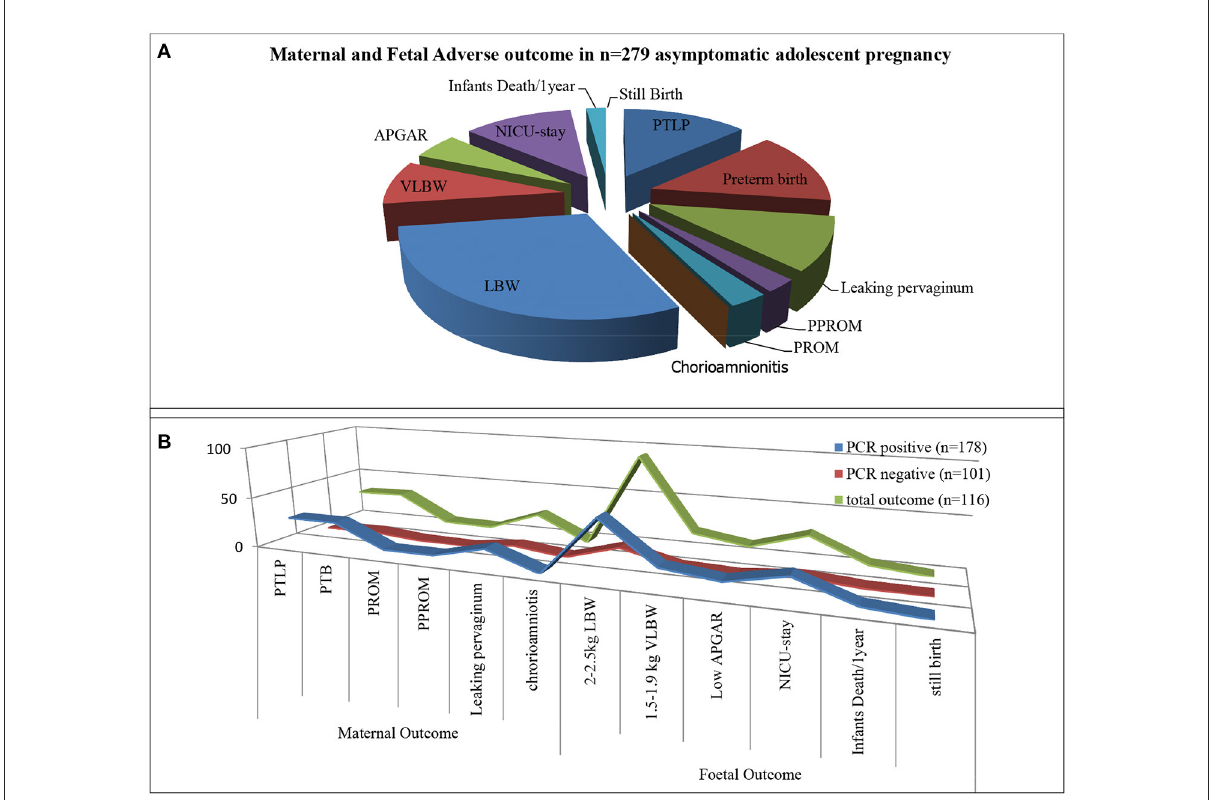
FIGURE5 Infection and maternal and fetal outcome. (A) Total adverse pregnancy outcome observed in asymptomatic adolescent. (B) Represent adverse pregnancy outcome observed in PCR tested positive group (blue strip), PCR tested Negative group (Red strip) from total adverse outcome (green strip).